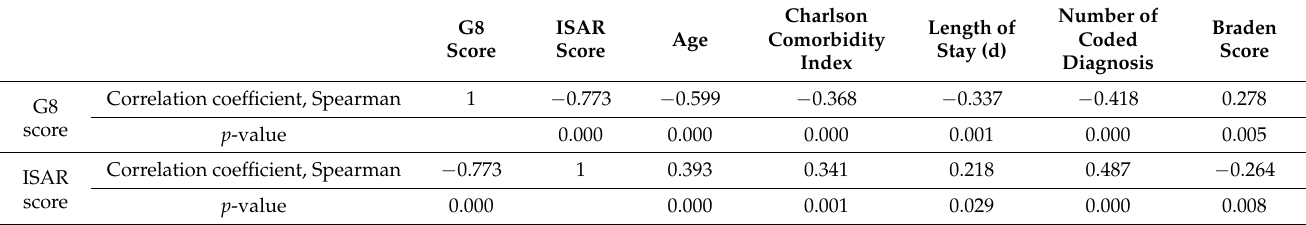
Table 2. Correlation (Spearman) between G8 and ISAR score results and age, Charlson comorbidity index, length of stay (d), number of coded diagnosis, and Braden score. Abbreviations: d =